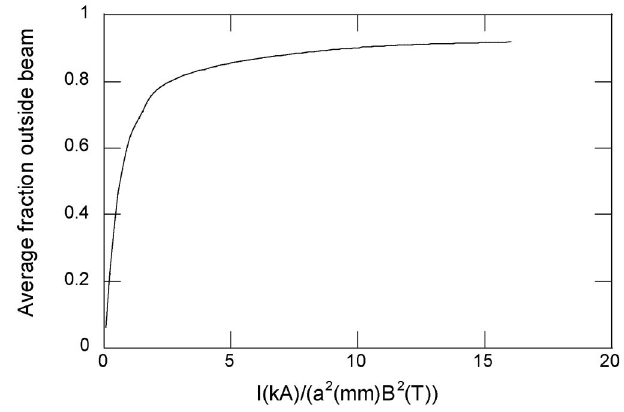
FIG. 2. Fraction of ionization electrons outside primary beam, as a function of the scaling parameter I= (cid:2) a 2 B 2